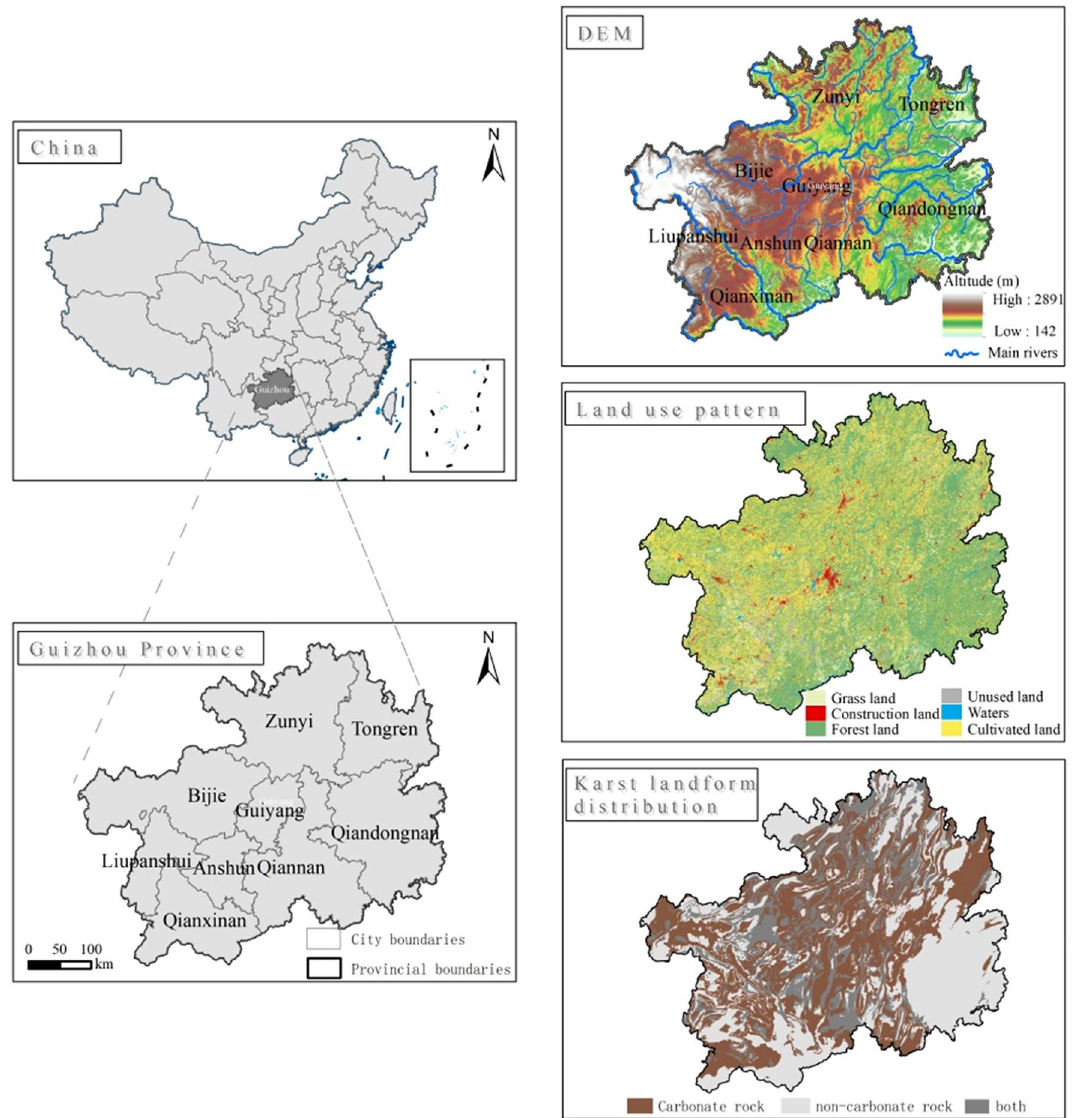
Figure 1. Overview of the study area. The study area map was created by ArcMap 10.6(http:// www. esri. com/ index. html) , using the data from CAS (http:// www. csdb. cn/)